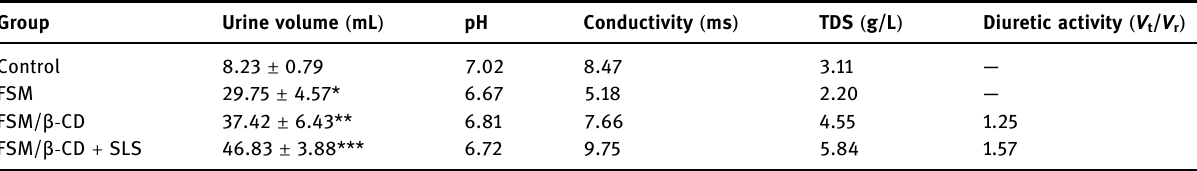
Values represent the mean ± SEM ( n = 6 ) . Data were analyzed using one - way analysis of variance ( ANOVA ) followed by Tukey ’ s test. * p < 0.05, ** p < 0.01, *** p <